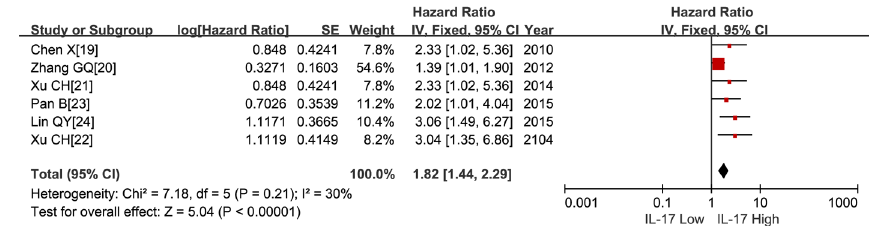
Fig 2. Meta-analysis comparing IL-17 expression and overall survival (OS) in lung cancer patients. The individualand pooledHR with 95% CI was shown by forest plot. HR > 1 impliedworse OS for the group with high IL-17 expression.